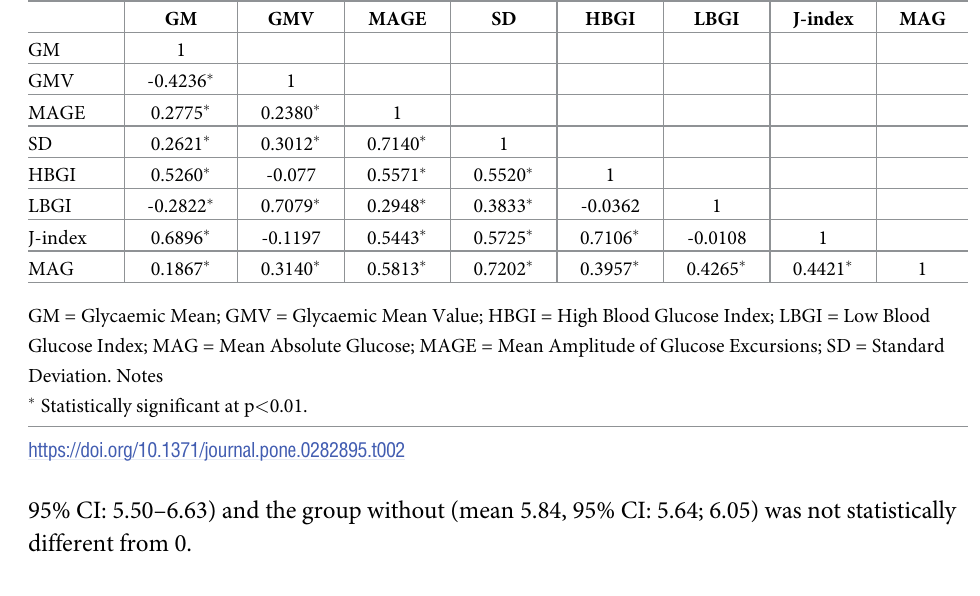
95% CI: 5.50–6.63) and the group without (mean 5.84, 95% CI: 5.64; 6.05) was not statistically